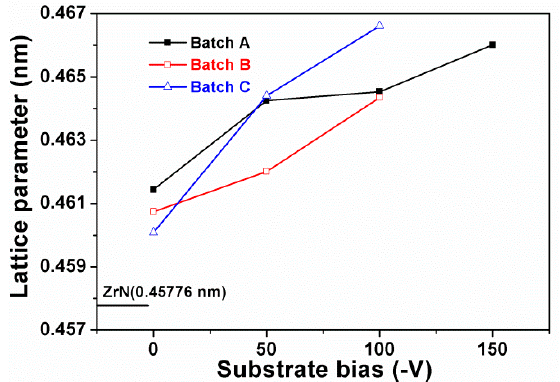
Figure 6. Lattice parameters of Zr–Si–N films fabricated under various substrate holder bias voltages.